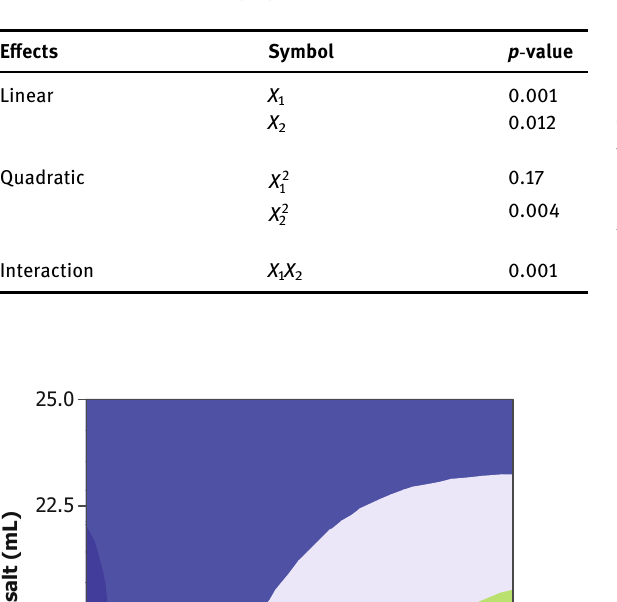
Table 3: Signi fi cance probability ( p - value ) of regression coe ffi -